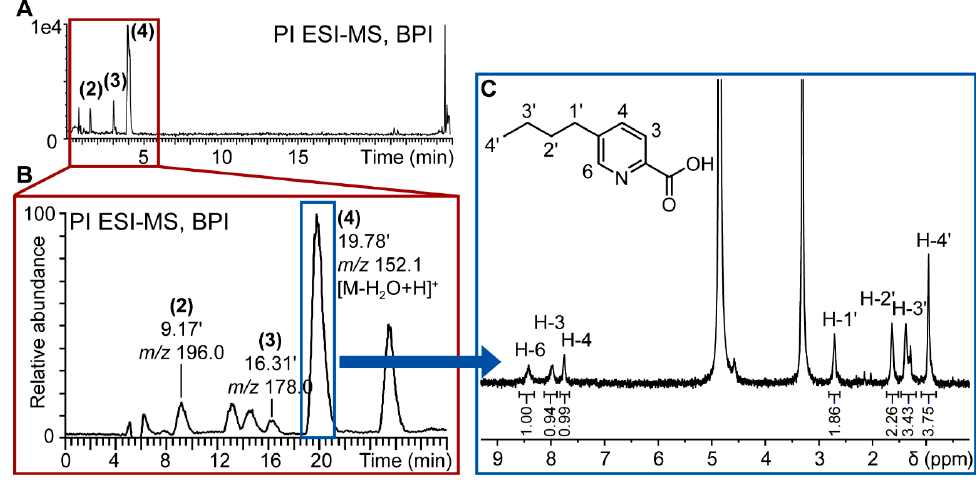
Figure 4. Workflow for targeted isolation of induced compounds in fungal co-culture extracts. ( A ) Base peak ion (BPI) chromatogram of positive ionization (PI) UHPLC-TOFMS metabolite profiling of F. cf. oxysporum and S. cf. strictum co-culture; ( B ) PI MS chromatogram of semi-preparative purification of S. cf. strictum and F. cf. oxysporum co-culture extract. The targeted induced compounds eluted at 9 ( 2 ), 16 ( 3 ) and 19 ( 4 ) min. The chromatographic gradient had been geometrically transferred for optimal comparability of analytical and semi-preparative scale chromatography; ( C ) 1 H-NMR spectrum of de novo induced compound ( 4 ) that corresponds to fusaric acid. Spectrum acquisitioned in CD 3 OD on CapNMR™ probe (500 MHz spectrometer, Varian Inc., Palo Alto, CA, USA; probe: Protasis/MRM, Savoy, IL, USA) at 25 °C with 128 transients. The structure of fusaric acid, the assignments and the integrals (normalized to resonance at 8.41 ppm) are given in the spectrum.